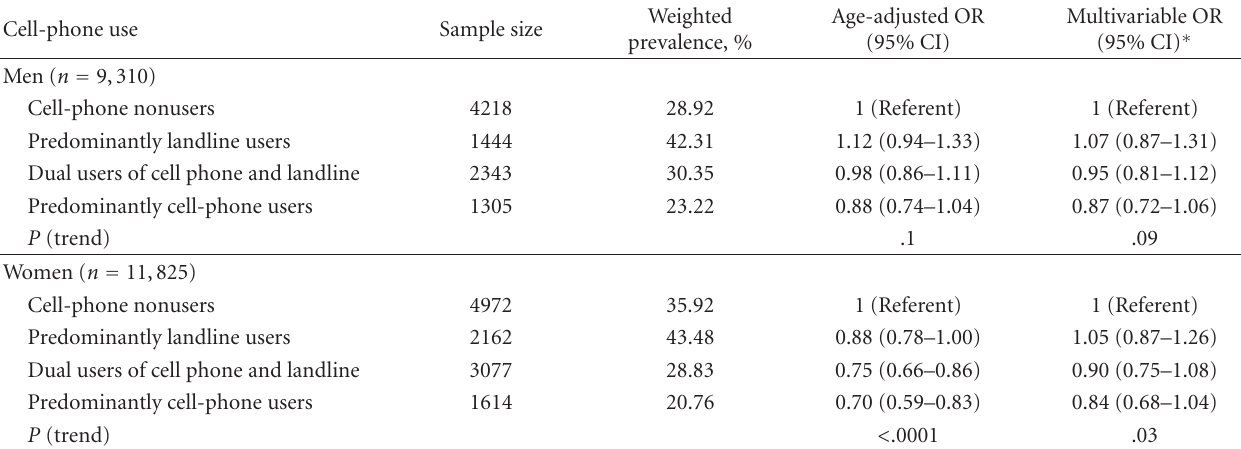
Table 4: Association between cell-phone use and hypertension by